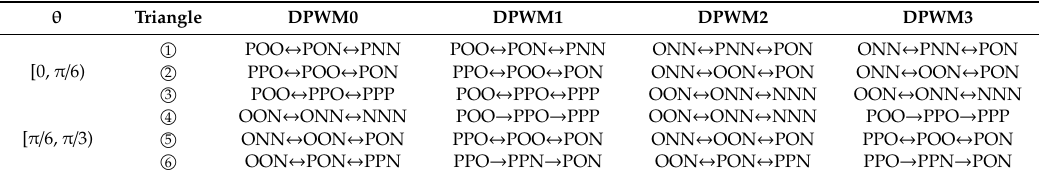
Table 3. Switching sequences of discontinuous pulse width modulation (DPWM): DPWM0–DPWM3 in sector Z I Reproduced with permission from [19].